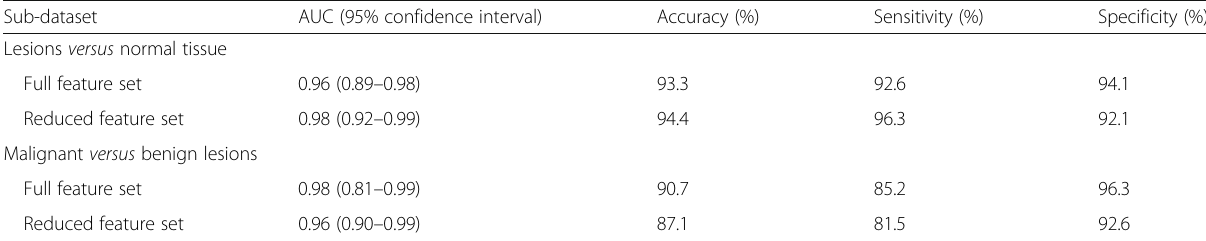
Table 4 Area under the curve (AUC), accuracy, sensitivity, and specificity achieved with the validation set in the classification of lesions versus normal tissue and malignant versus benign solid lesions using the full texture feature set and the reduced feature